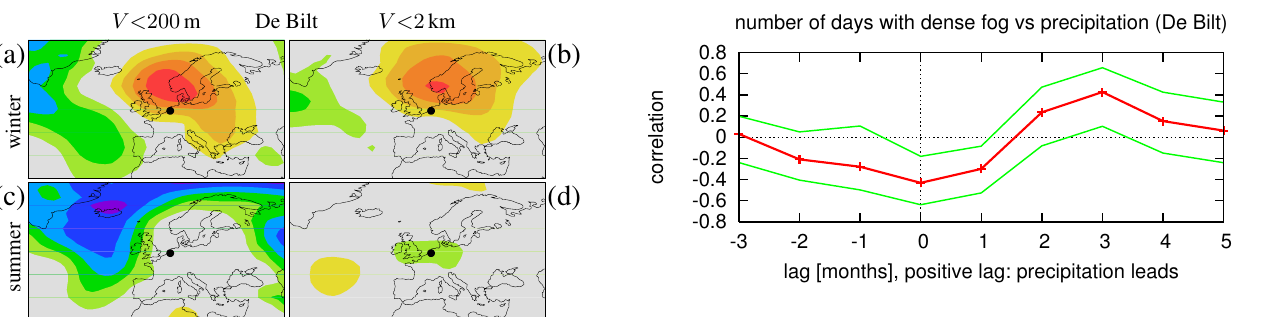
Fig. 8. Regression of the seasonal mean sea-level pressure on the number of days with low visibility in De Bilt [Pamonth], the Netherlands (dot) in winter (a) and (c) , and summer (b) and (d) . In (a) and (c) the regression of days with dense fog (visibility less than 200m) is shown, in (b) and (d) the regression of days with visibility less than 2km.